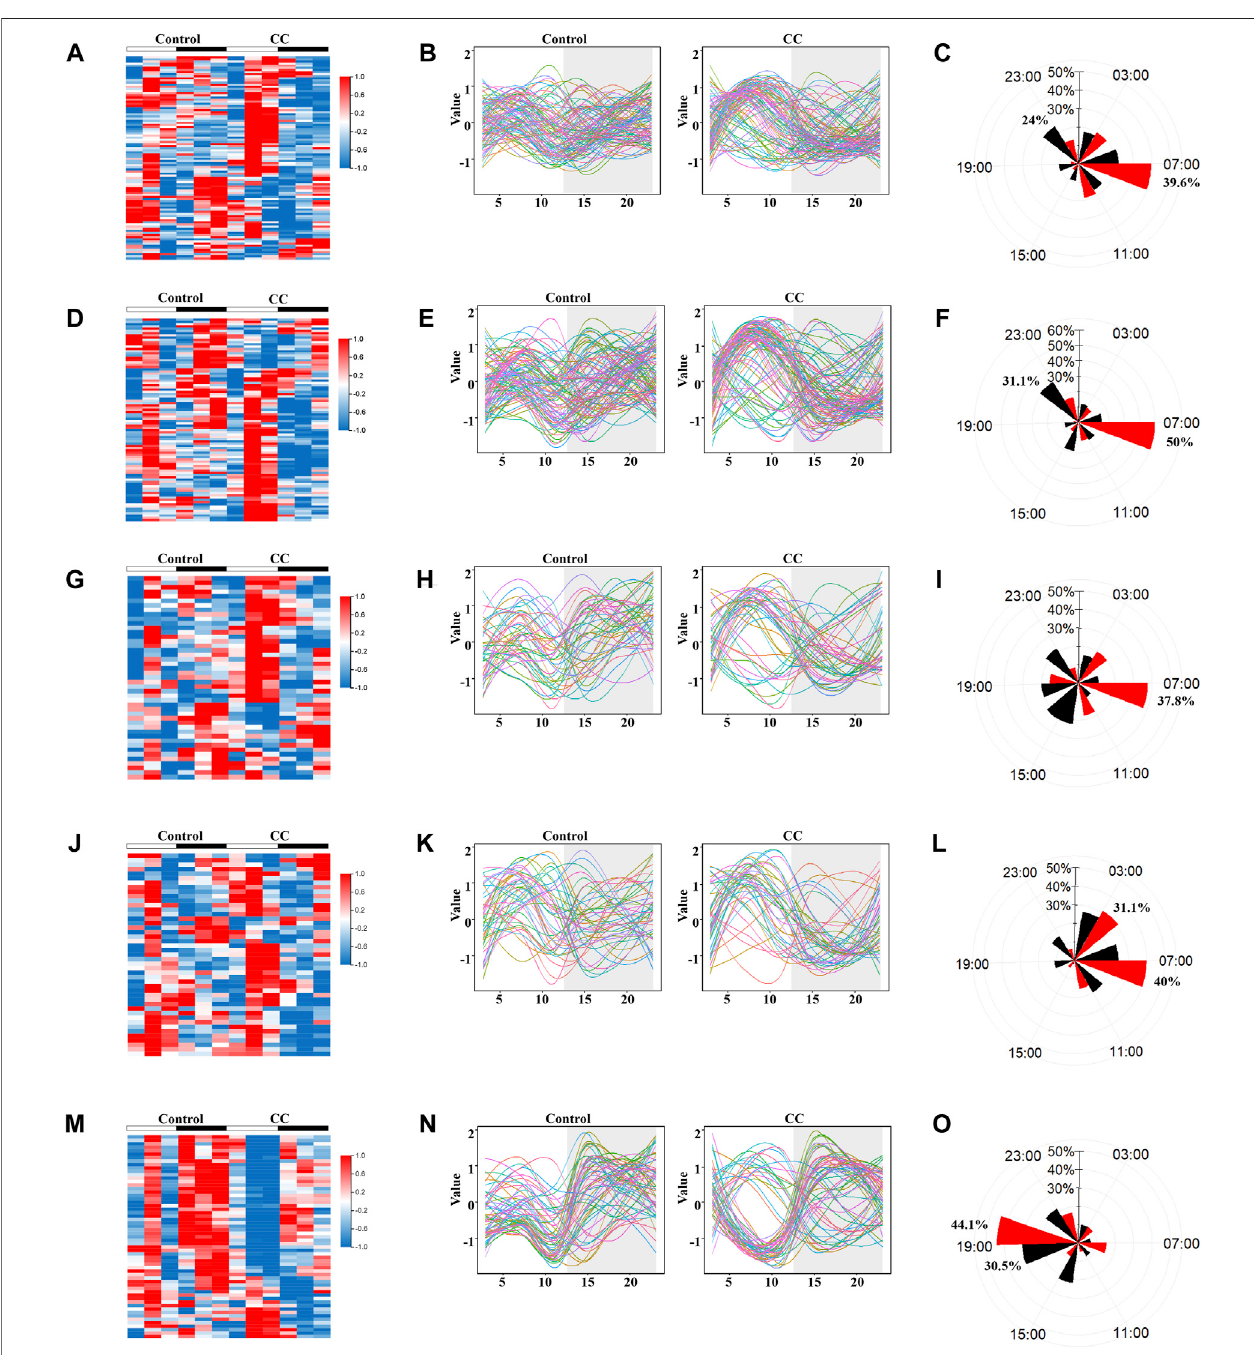
FIGURE 5 | Chronic cold exposure triggers the synchronization of oscillatory metabolic gene expression. KEGG pathway enrichment analysis was performed on the Ⅲ and Ⅳ liver group genes ( Figure 3C ), and genes related to metabolic pathways were selected for rhythm analysis. Heat map of genes enriched in control and chronic cold (CC) groups; colorrepresents Z-score-normalized expression; each sampleis represented by acolumn, and a linerepresentseach metabolite. Each linein the fi tted curve represents a gene, with expression levels represented as a Z-score of the mean ( n = 3), random colors, and time points on the horizontal axis (ZT). The radar plots of acrophase with a black line representing the control group, and a red line representing the chronic cold group. (A – C) Lipid metabolism genes (D – F) , carbohydrate metabolism genes, (G – I) energy metabolism genes, (J – L) thermogenesis genes, and (M – O) the protein processing in endoplasmic reticulum genes.